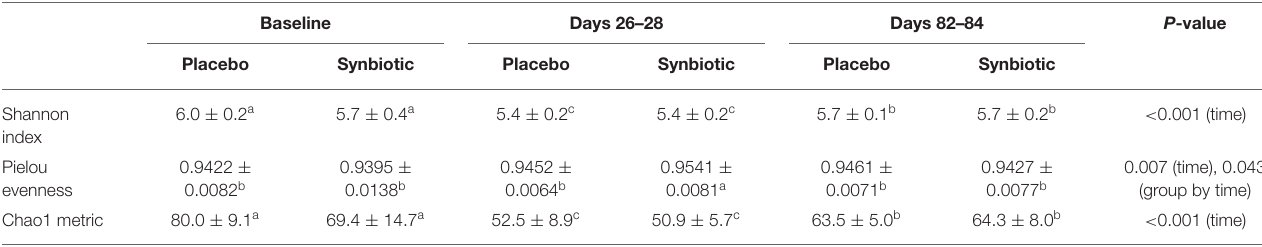
TABLE 1 | Mean ± standard deviation (SD) results for alpha diversity metrics collected at the conclusion of baseline (days 5–7), antibiotic administration (days 26–28), and a 56-day washout (days 82–84) from 22 healthy dogs, 11 per group, + that received enrofloxacin (10 mg/kg qd) and metronidazole (12.5 mg/kg BID), followed 1h later by placebo or a synbiotic combination (BID) PO for 21